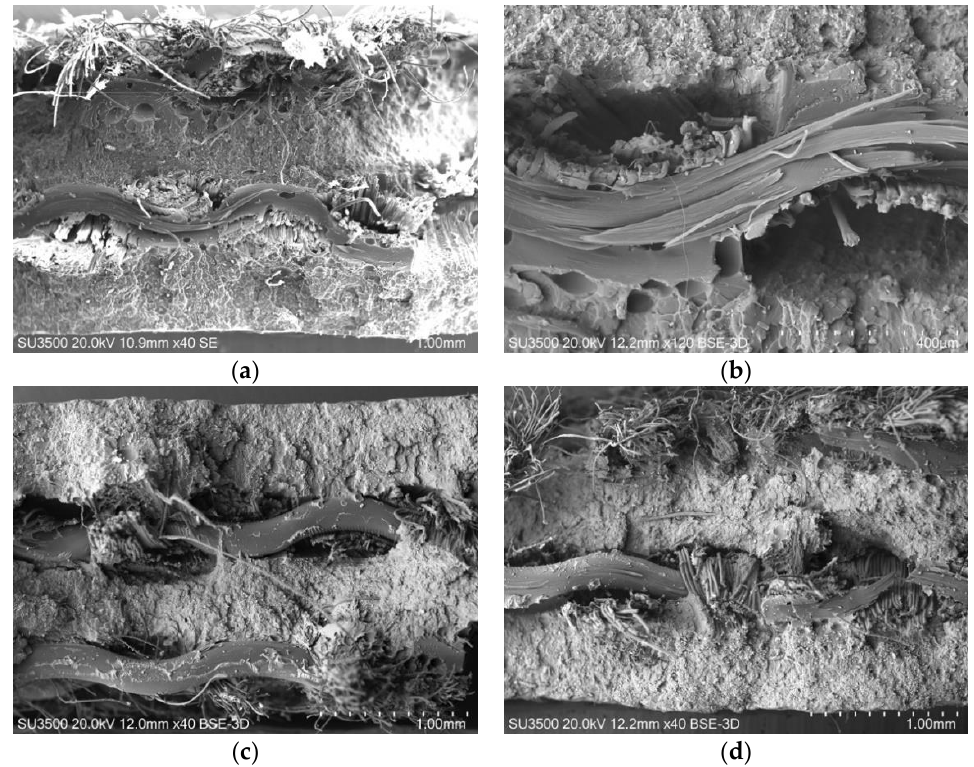
Figure 12. SEM images view of cross-section after the failure of material samples subjected to the thermal shock chamber tests: ( a ) KSZA; ( b ) KSZB; ( c ) KSZC and ( d ) KSZD.